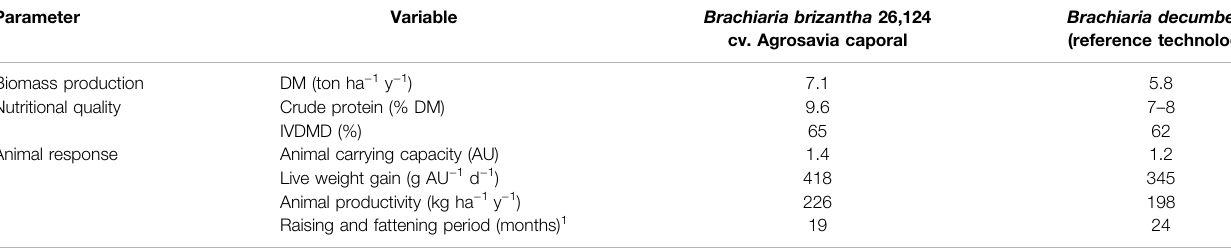
TABLE 1 | Dry matter production, nutritional quality and animal response of the evaluated grasses.